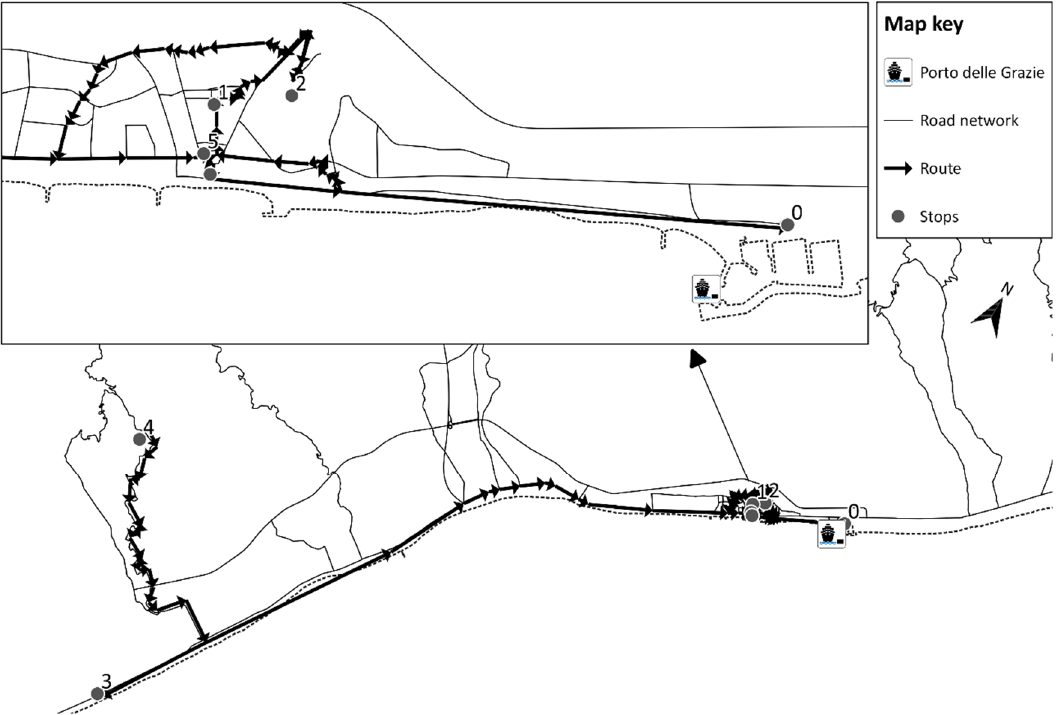
Figure 6. Example of route analysed.